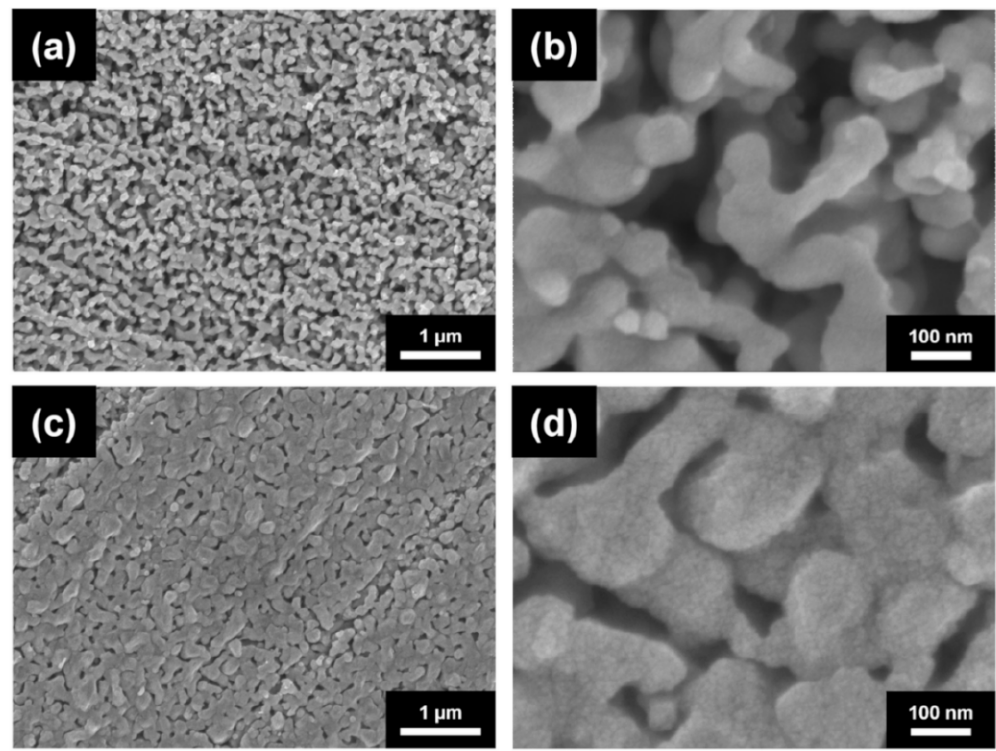
Figure 10. SEM images of Cu nanofoams oxidized at ( a , b ) 170 ◦ C for 30 min and ( c , d ) 200 ◦ C for 30